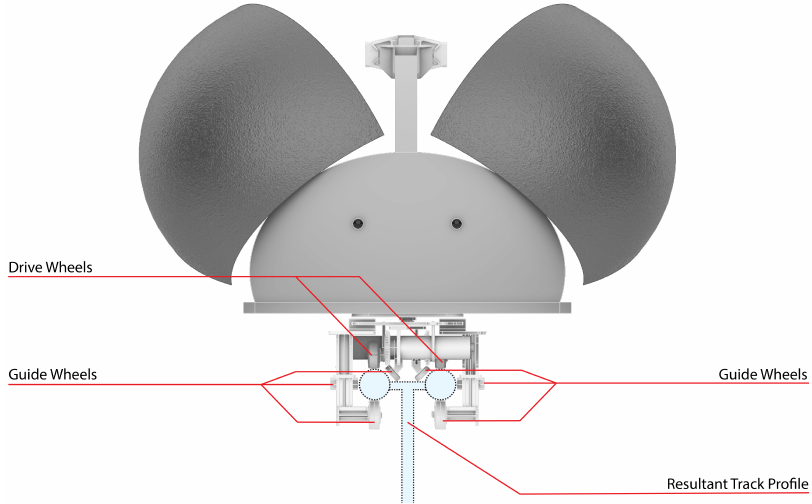
Figure 2. Front view of robot showing wheel